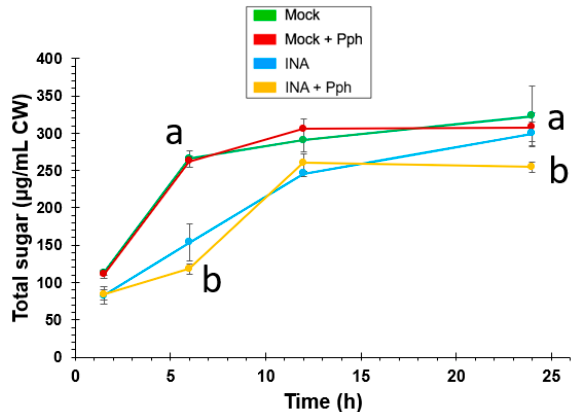
Figure 9. Time course of sugars released by enzymatic hydrolysis of CWs extracted from Mock, Mock + Pph, INA and INA + Pph conditions. Data represent mean ± SE ( n = 3). Statistical analysis was carried out by two-way ANOVA where letters indicate significant differences by Tukey test ( p < 0.05).